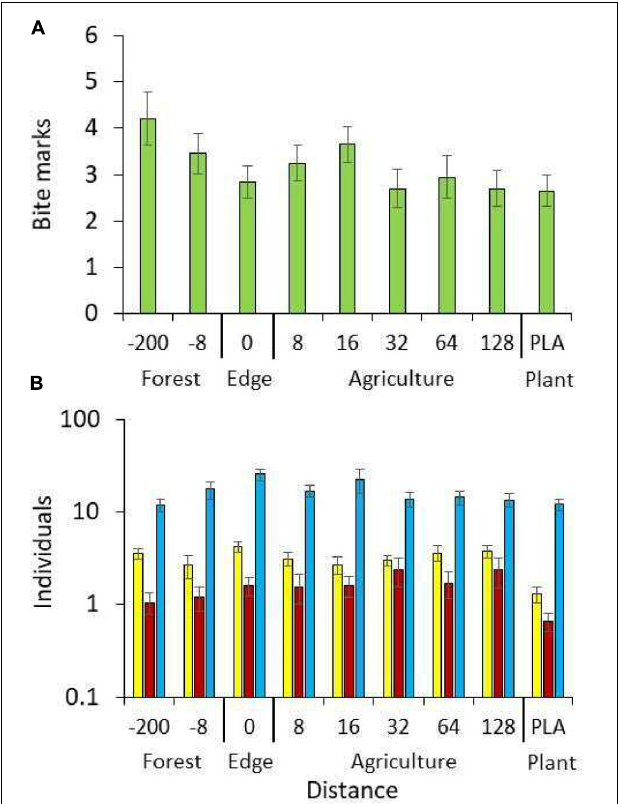
FIGURE 6 | Mean numbers of dummy bitemarks (A) and individuals caught with pan traps ( B: yellow: Hymenoptera, brown: Coleoptera, blue: Diptera) in dependence on distance to the forest. Plantation data (Plant) are shown separately. Error bars denote standard